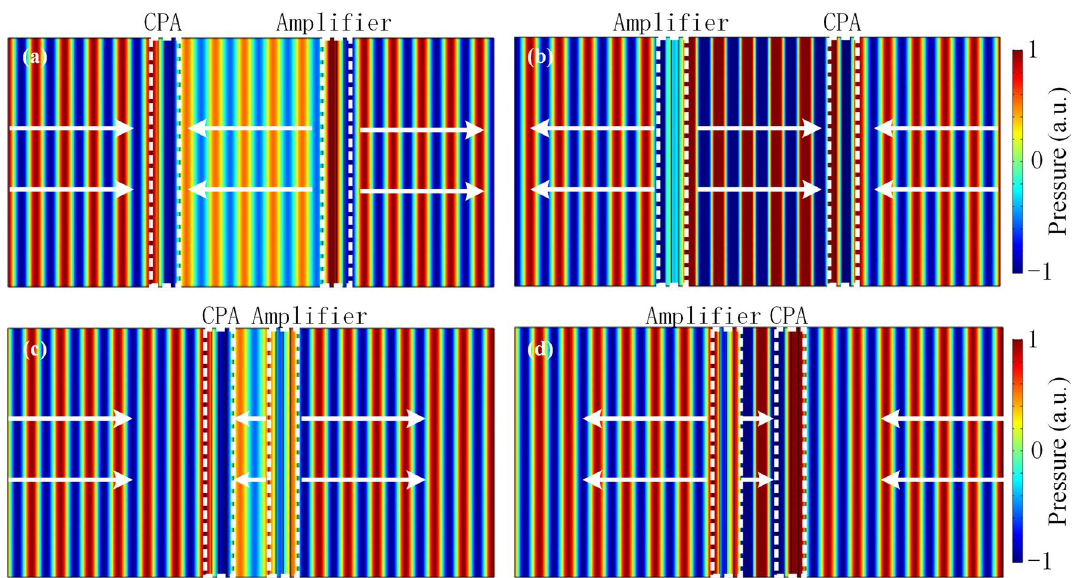
Figure 4. Pressure field distributions of the bidirectional acoustic negative refraction system for the normally incident plane wave at the operating frequency of f = 3,400 Hz. The distances between two metasurfaces are set to ( a ), ( b ) d = 500 mm and ( c ), ( d ) d = 125 mm, respectively. In ( a ) and ( c ), the plane wave is incident from the left side. In ( b ) and ( d ), the plane wave is incident from the right